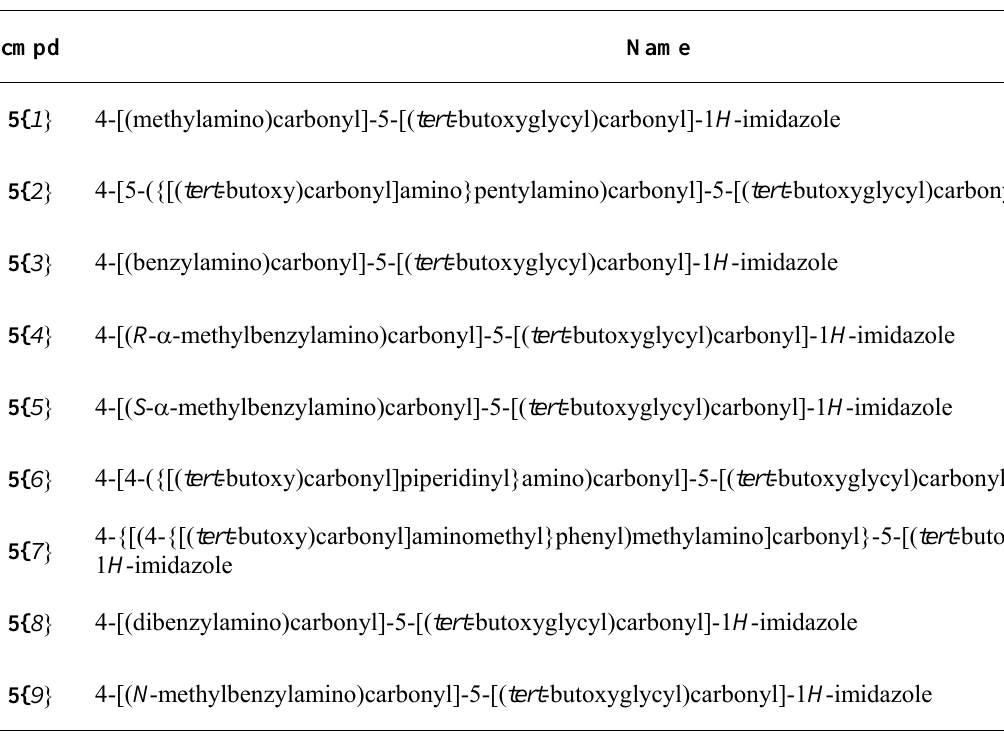
Table 7 . Final Product Numbers and